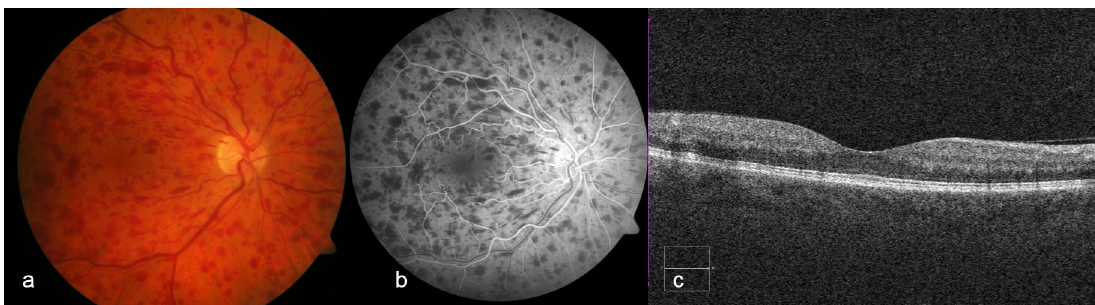
Fig 1. Patient example with CRVO. Fundus photography of the right eye with intraretinal hemorrhages (a). FA 34 s after dye injection showing blockage of retinal and choroidal fluorescence by intraretinal hemorrhages (b). Structural OCT reveals no cystoid macular edema